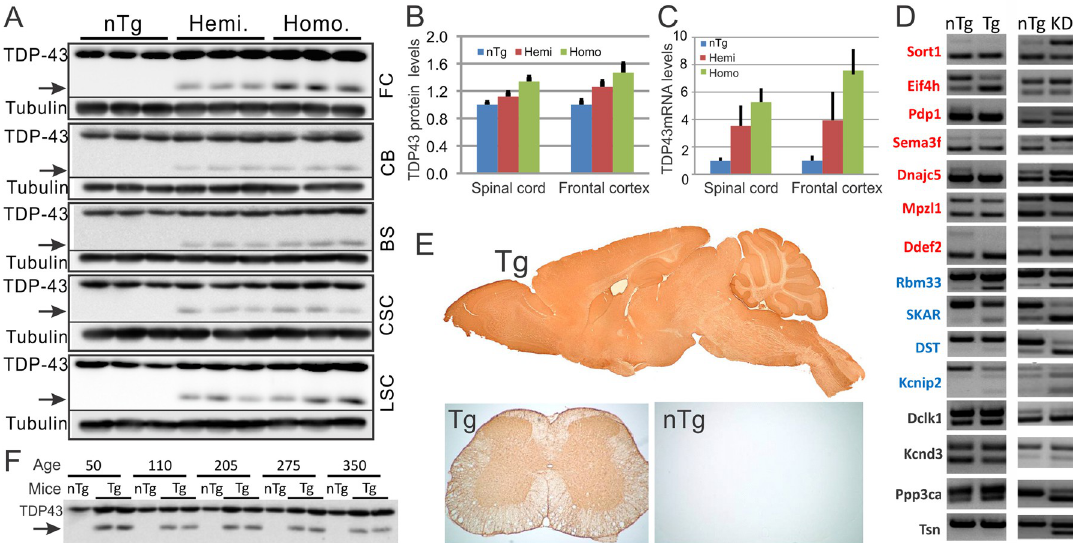
Fig 2. Transgene expression in the CNS of the hemizygous (Hemi.) and homozygous (Homo.) Tg mice. (A) A modest increase of TDP-43 protein in the frontal cortex (FC), cerebellum (CB), brainstem (BS), cervical (CSC), and lumbar spinal cords (LSC). Each lane represents one mouse. Notice that the 35-KD proteolytic fragment of TDP-43 was only detected in the transgenic mice but not in nTg controls. (B) Quantification of TDP-43 protein in (A) in FC and LSC. (C) Quantification of TDP-43 mRNA in FC and LSC. The number of animals used for FC quantification: nTg, 8; Hemi, 9; Homo, 11. For LSC: nTg, 9; Hemi, 12; Homo, 16. Error bars are standard deviation. (D) Comparing the alternative splicing patterns in the Tg mice vs. TDP-43 knockdown mice [45]. The PCR primers and the exon numbers are listed in S1 Table. (E) A sagittal section from a Tg mouse brain and a cross-section from either Tg or nTg mouse spinal cord were stained for GFP. Notice that the broad GFP staining throughout the Tg brain and spinal cord but not in the nTg. (F) Western blot showing stable TDP-43 protein levels in lumbar spinal cord in the TDP-43 Tg mice throughout different ages. The arrow points to the 35-KD fragment that is only present in the Tg mice.